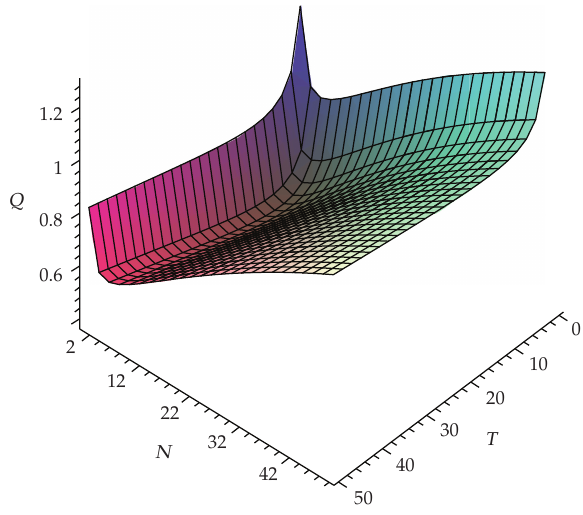
Figure 1: Cost function. Q (cid:6) T,N (cid:7)